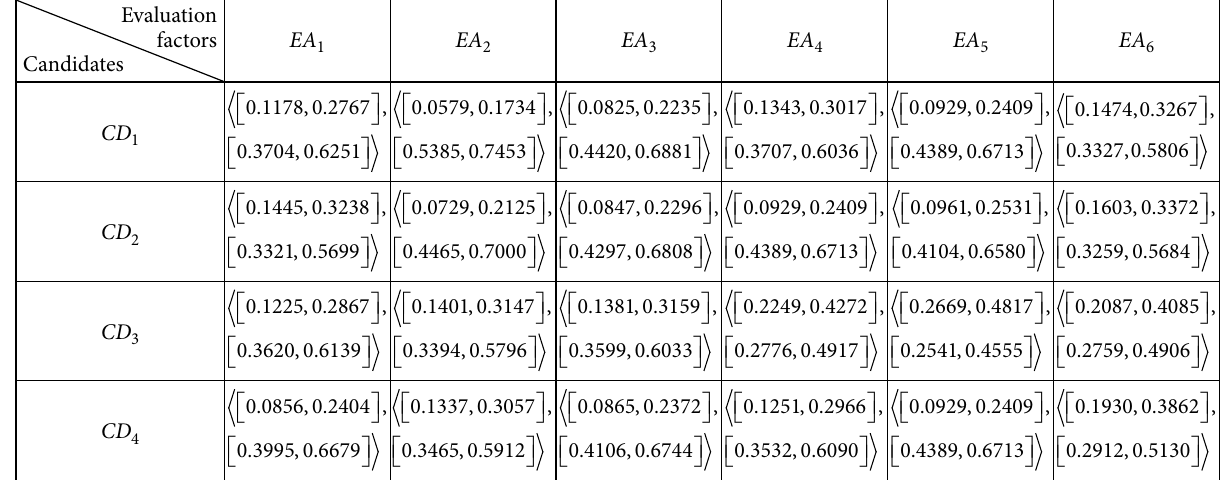
Table 7. Weighted aggregated IVIF matrix